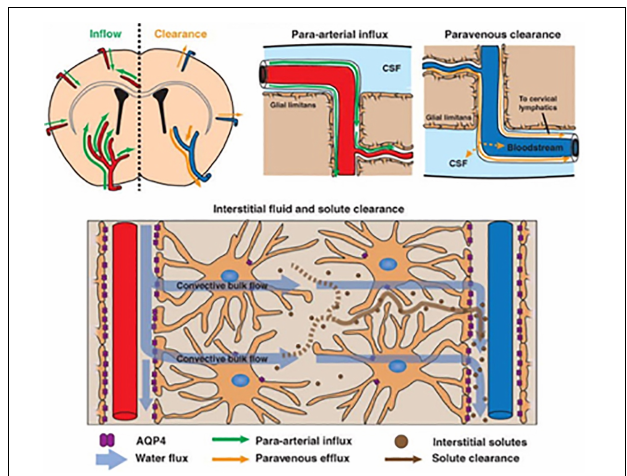
FIGURE 1 | The schematic shows glymphatic clearance of solute from perivascular space of penetrating arteries (top right) across the brain parenchyma by convection into the perivascular space of penetrating veins. Adapted from Iliff et al.